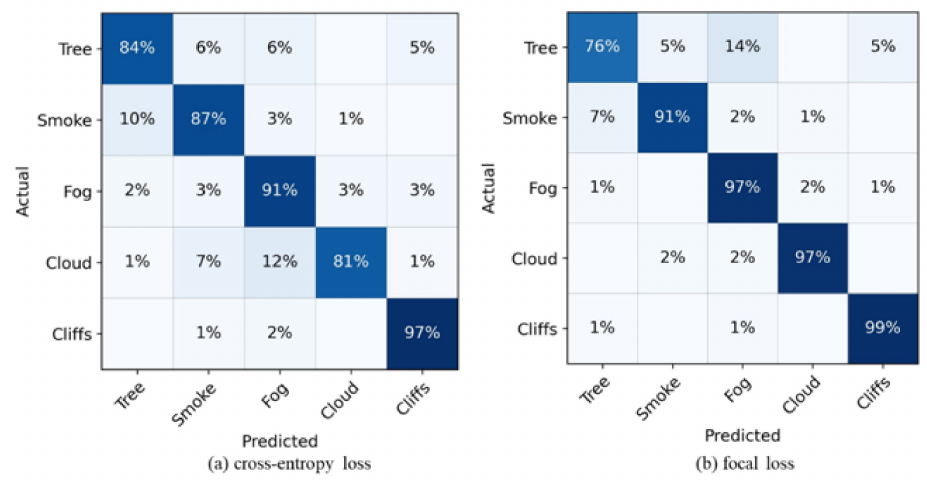
Figure 4. Test results of ( a ) cross-entropy loss function and ( b ) focal loss function on FF_Smoke dataset.